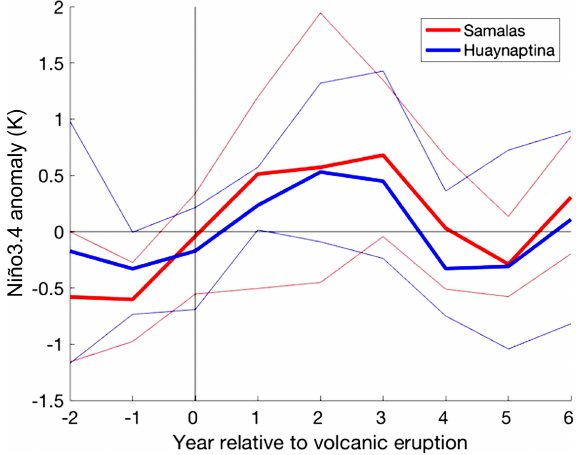
Figure 7. Mean NINO3.4 response of all volcanic ensembles (four CR ensembles and one 2 × G ensemble) to the largest (1258 Samalas) and smallest (1600 Huaynaputina) eruptions analysed over DJF. The bold lines represent the mean of all volcanic ensem- bles to each eruption, and the fainter lines represent the 90th and 10th percentile of the ensemble